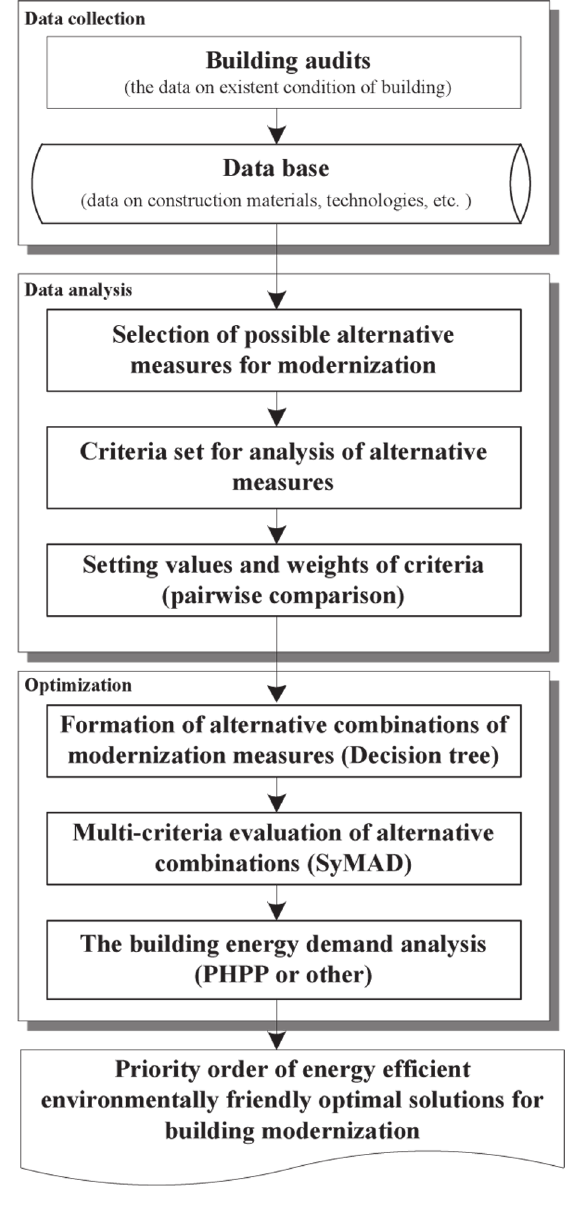
Fig. 1. the proposed decision